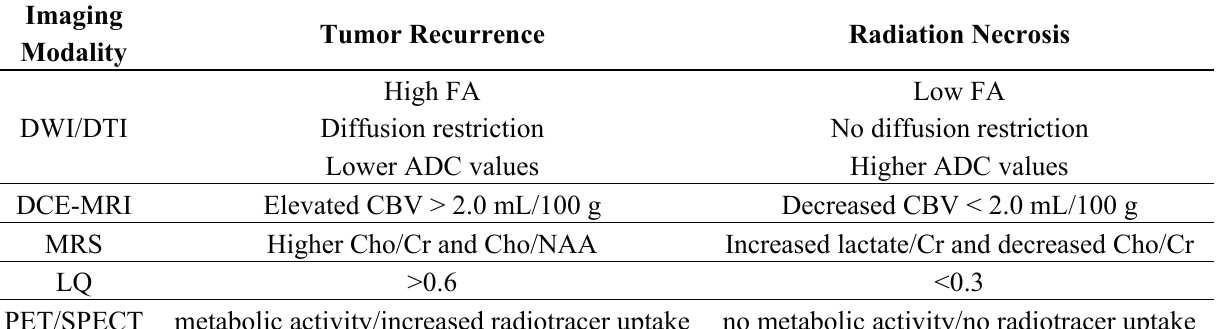
Table 1. Differentiating between tumor recurrence and radiation necrosis using different diagnostic imaging